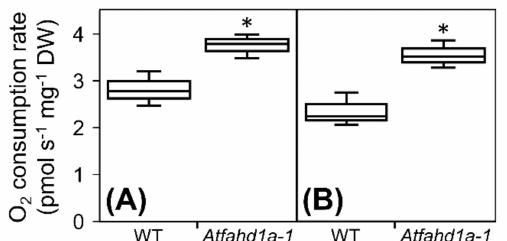
Figure 4. Oxygen (O 2 ) consumption rate of wild type seeds (WT, ecotype Columbia-0 [Col-0]) and Atfahd1a-1 (fumarylacetoacetate hydrolase domain-containing protein 1a) T-DNA insertional mutant seeds in the Col-0 background during the first 2 h after the onset of imbibition at 21 ◦ C. ( A ) Maximal respiration rate corrected for basal respiration. ( B ) Activity of mitochondrial complex IV calculated by subtracting from corrected maximal respiration the respiration measured after exposing seeds to 25 mM KCN. Data are shown as box-plots ( n = 4 replicates of ca. 10 mg of seeds of both lines) and were obtained from the second plant generation. Results were normalised on a dry weight (DW) basis. Asterisks denote significant differences between WT and Atfahd1a-1 seeds ( t -tests, p <